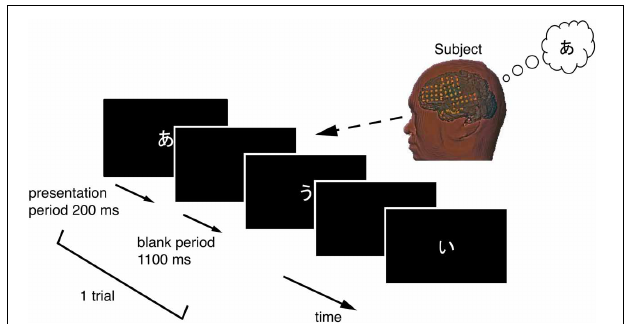
FIGURE 2 | Temporal sequence in the vowel-articulating task. The solid arrow indicates the time-line. Each trial consisted of a presentation period followed by a blank period. The subject covertly articulated the vowel one single time during the blank